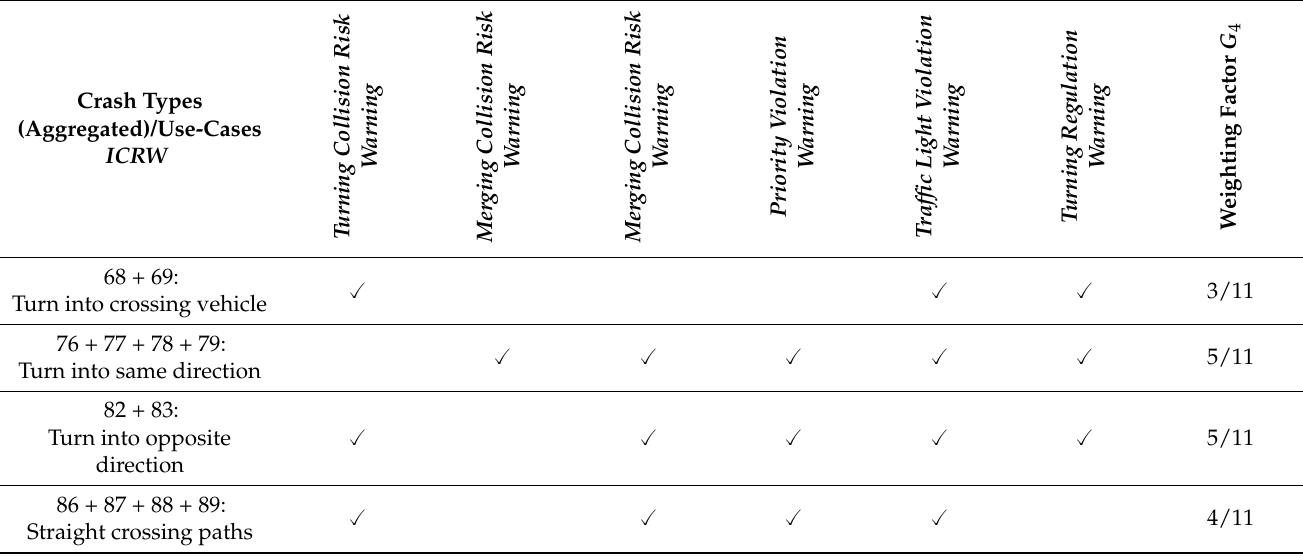
Table 6. Applicability of V2V + V2I use-cases of ICRW to the scenarios under investigation and calculation of the weighting factor